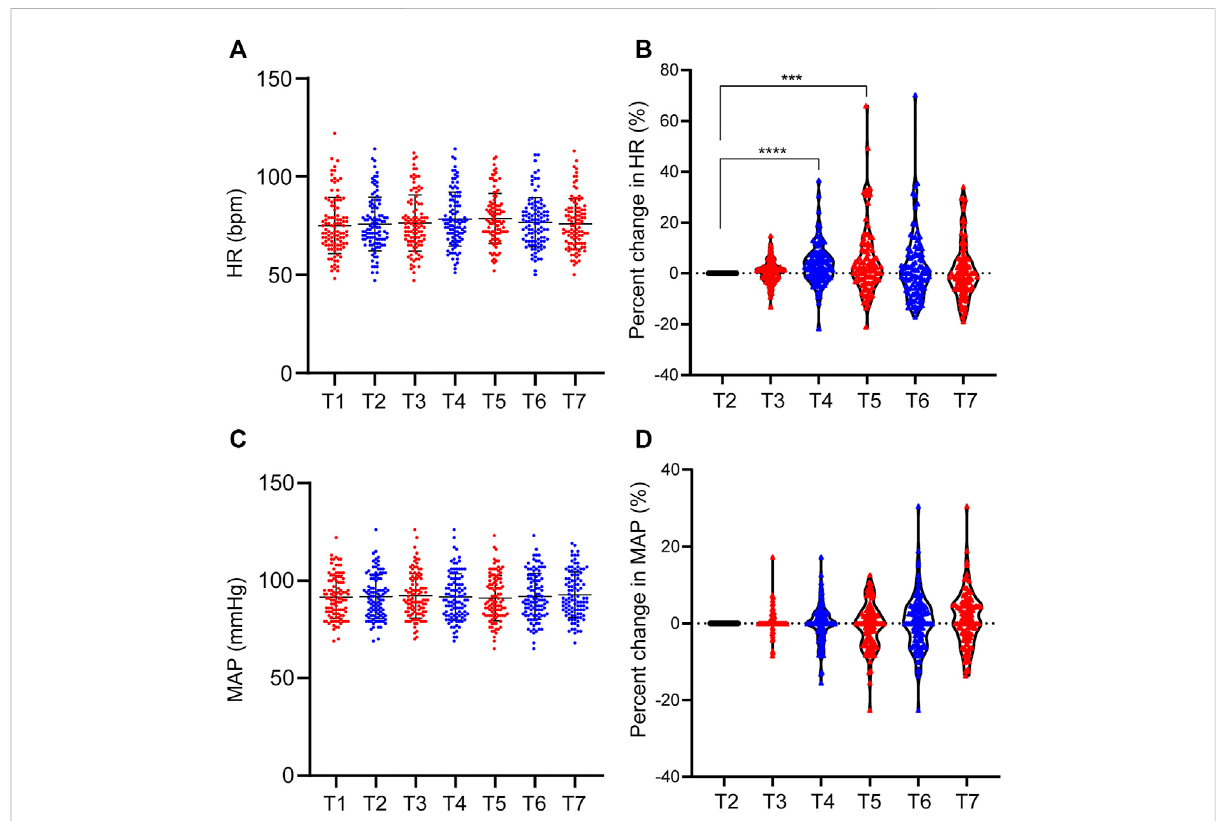
FIGURE 3 Individual differences in MAP and HR during etomidate anesthesia. (A) MAP distribution of patients at each time point; (B) MAP change rate at each time point; (C) HR distribution of patients at each time point; (D) HR change rate at each time point. T1, 5 min after the patients entered the room; T2, before the administration of etomidate; T3, 30 s; T4, 60 s; T5, 90 s; T6, 120 s; T7, 150 s after the etomidate. *** p < 0.001, **** p <